Question: What visual encoding does this figure use to show its data?
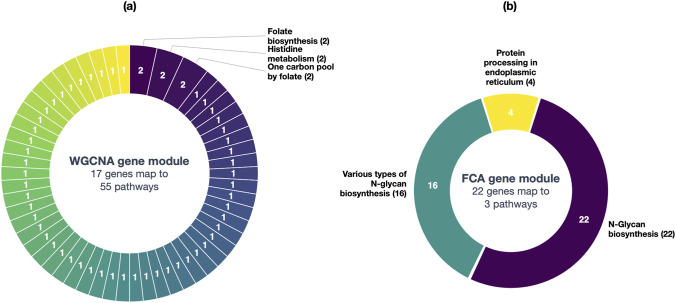
Answer: scatter